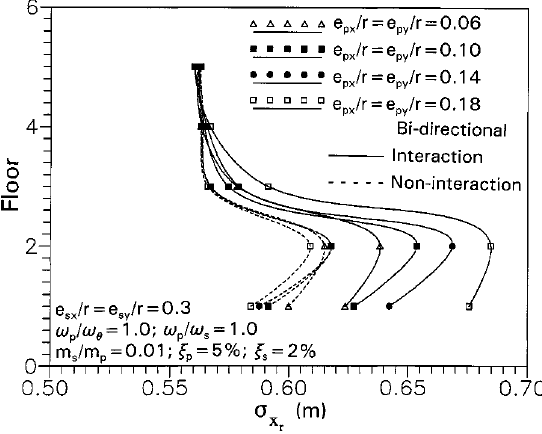
Fig. 2. Variation of (cid:27) x with storey height for various values of r e p x =r and e p y =r ; for m s =m p = 0.01; ! p =! s = 1.0; ! p =! (cid:18) = 1.0; e